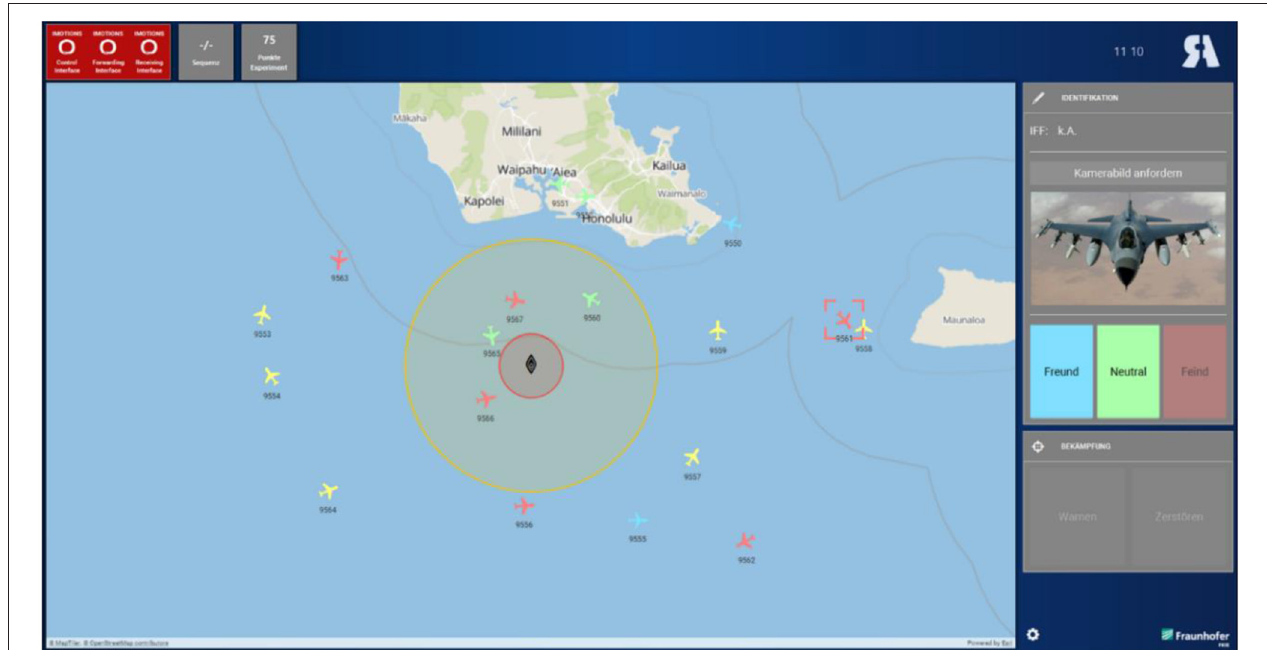
FIGURE 5 | Screenshot of the experimental testbed (based on RATE for C2).